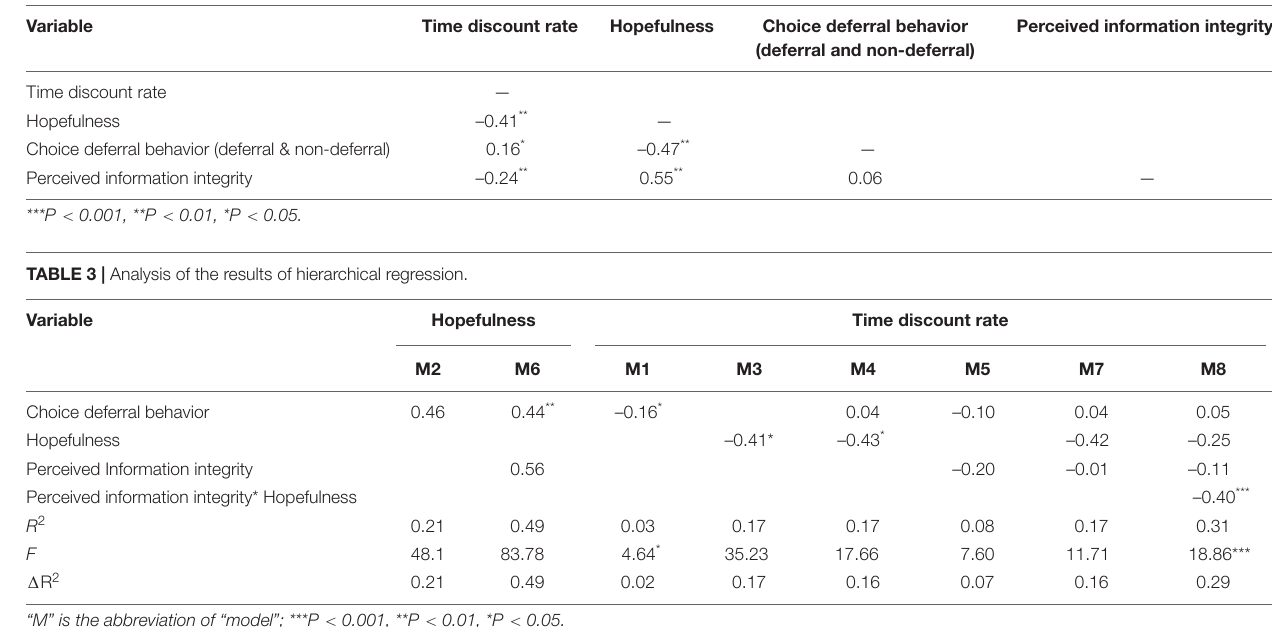
Table 3 we learn that: (1) time discount rate regressions